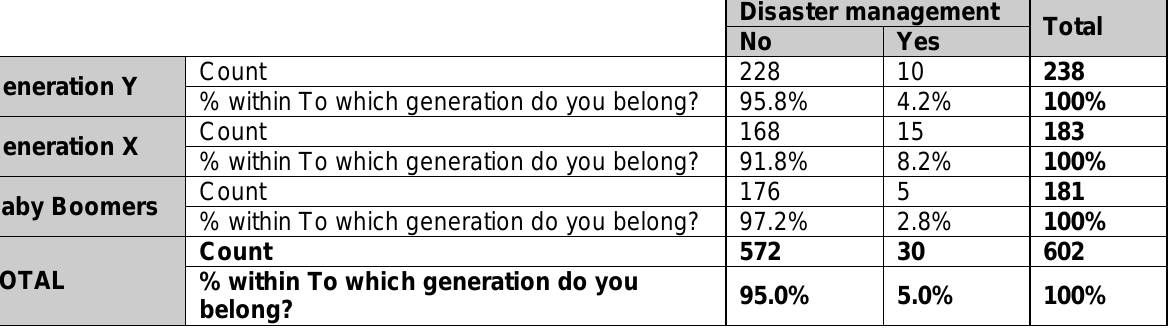
Disaster management